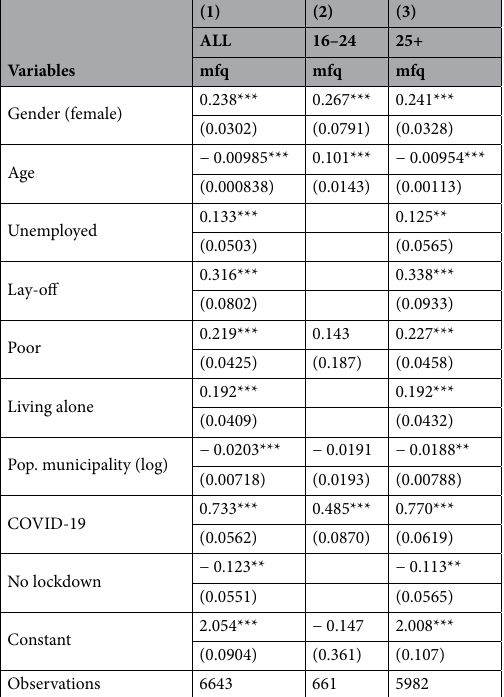
Table 6. Result of econometric models on the SMFQ score: young adults vs. adults. ( * ) Note: The estimates in the table refer to Poisson count models with double censoring (left at 0, right at 26), sample weights and robust standard errors. The dependent variable is the SMFQ score. For each variable, the coefficient, the standard error (in parentheses), and the level of significance are reported as follows: *** significant at 99%; ** significant at